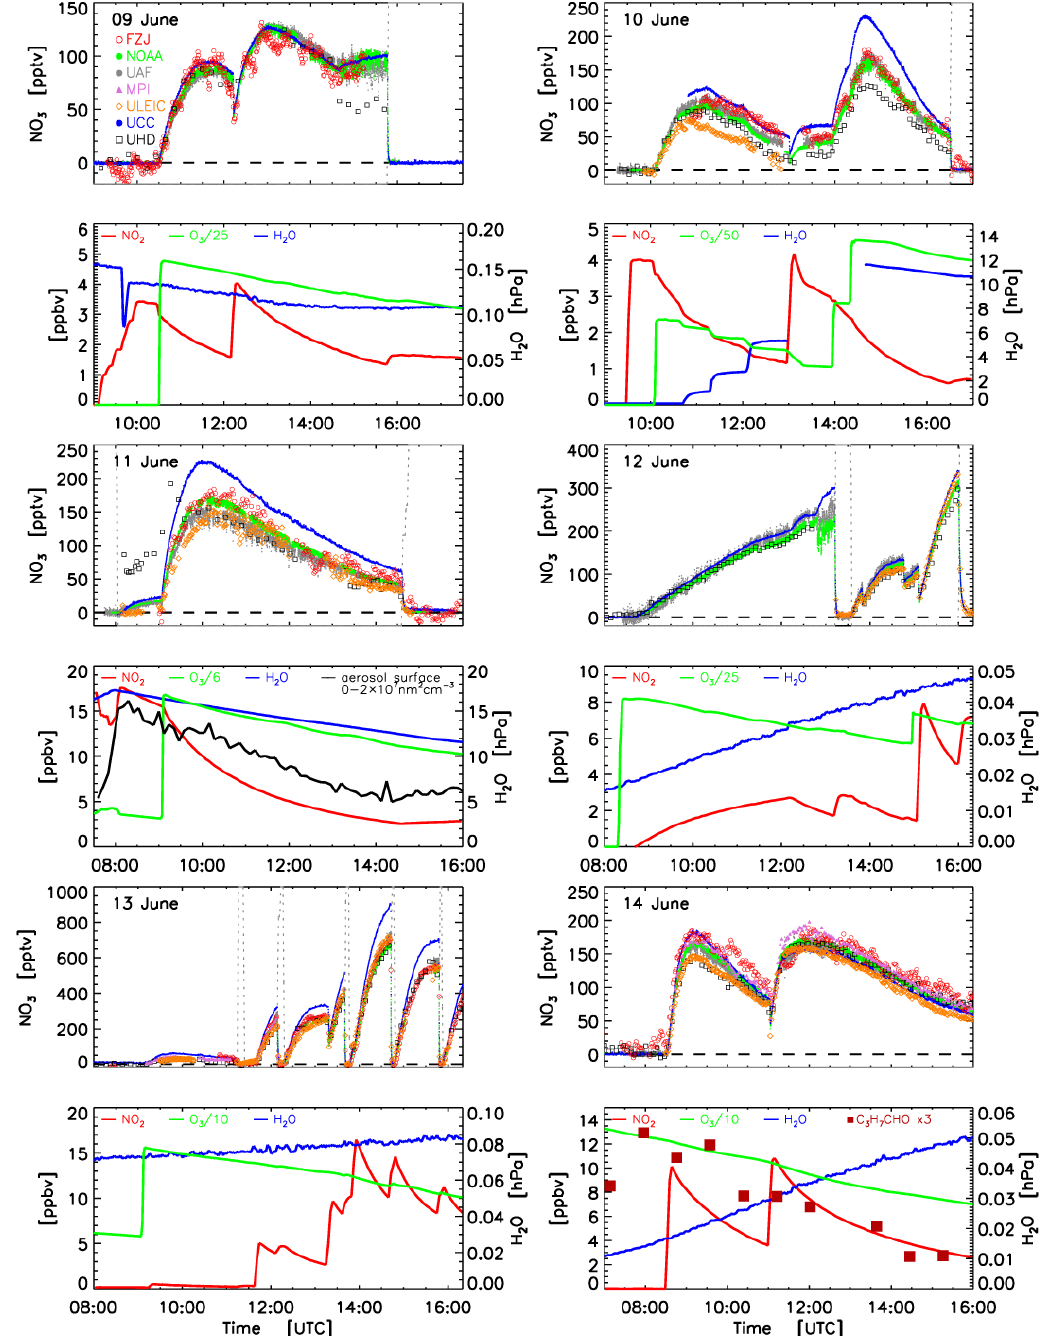
Fig. 3. Comparison of temporal profiles of NO 3 mixing ratios and supporting measurements of other relevant species (as indicated in the panels) for all days of the intercomparison campaign. The respective upper panels show NO 3 data measured with the original time resolution of the instruments (NOAA-CRDS 1s, UAF-CRDS 1s, UCC-IBBCEAS 5s, MPI-CRDS 10s, FZJ-DOAS 60s, ULEIC-BBCRDS 61s, and UHD-CEDOAS 300s). Vertical, dashed grey lines indicate times when the roof of the chamber was opened or closed to initiate photolysis or enable the build-up of NO 3 , respectively. The associated lower panels present the mixing ratios of NO 2 , O 3 , hydrocarbons (ppbv, left axis), and the water vapour partial pressure (hPa, right axis). For experiments containing aerosol, the aerosol surface area concentration is indicated by a black line (in units of nm 2 cm − 3 , no separate axis associated, full data span specified in the